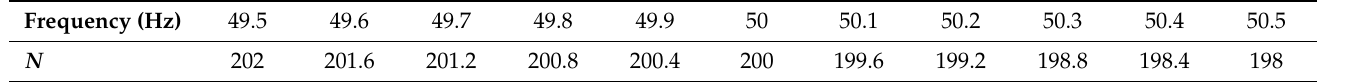
Table 2. The corresponding RC delay, N , when the grid frequency changes.